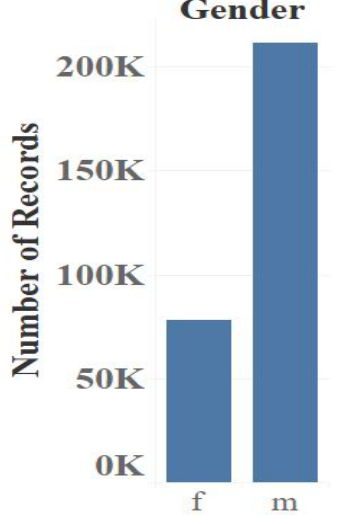
Figure 7. LastFM gender distribution.